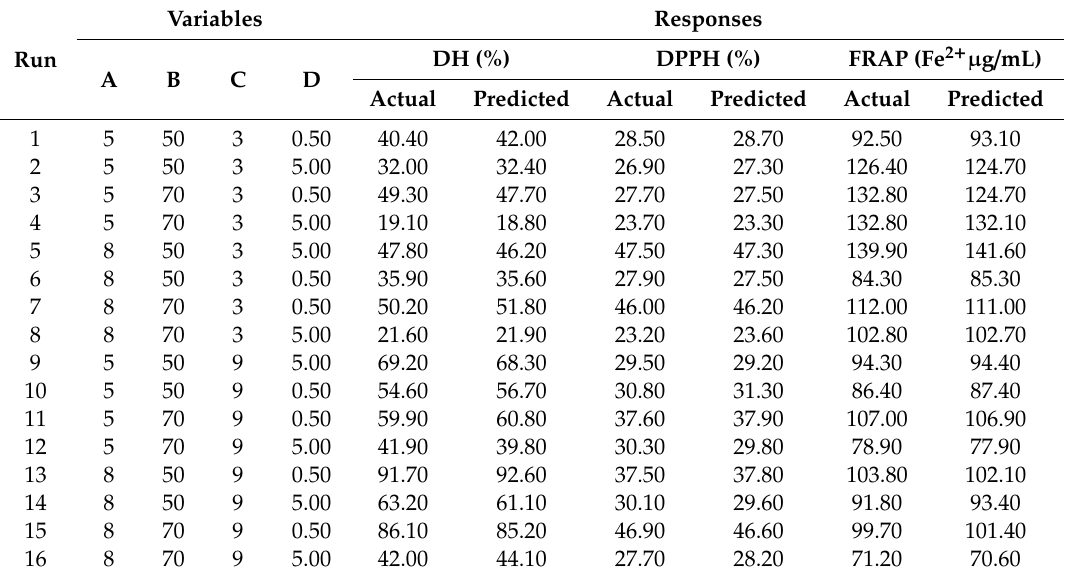
Table 2. Design matrix and responses of a two-level factorial